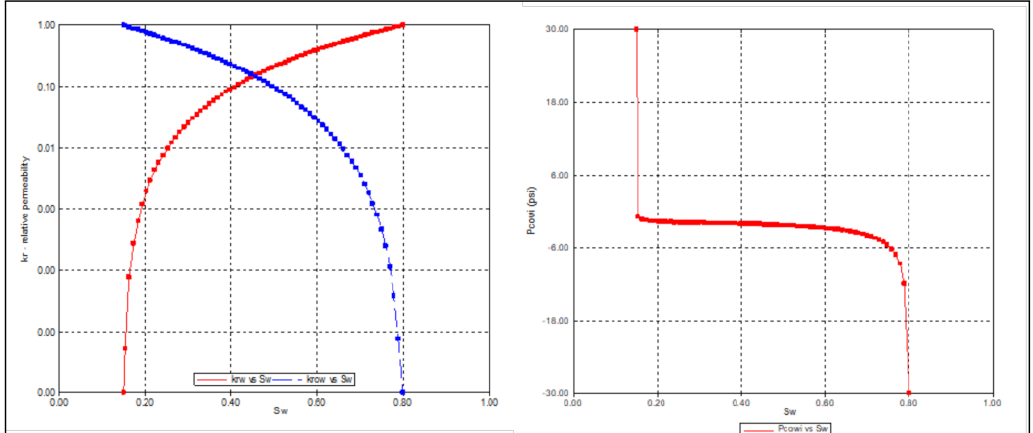
Figure A2. Oil-water relative permeability and capillary pressure curves for permeability below 100 mD (Modified and adapted from